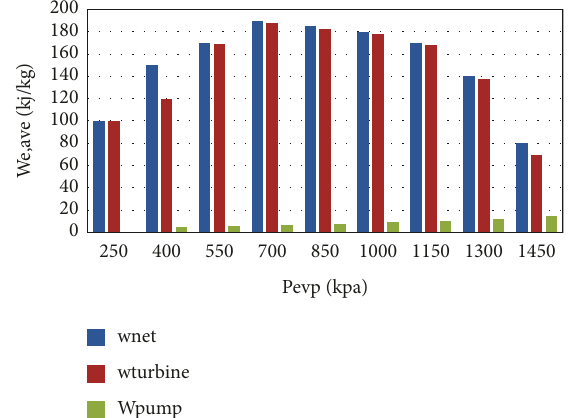
Figure 3: Changes in electricity generated by the organic Rankine cycle based on steam generator pressure.